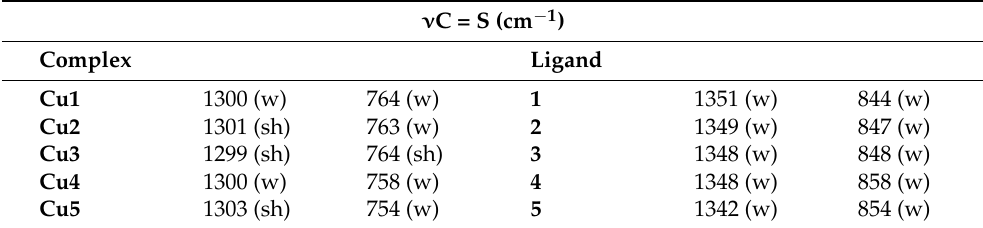
Figure 4. UV-Vis spectra in the range of 220–1400 nm for complexes Cu1–Cu5 . 2.2.3. XANES Comparative Analysis The copper oxidation state in the synthesized compounds was determined by XANES spectra comparative analysis. Therefore, we measured the Cu K-edge spectra of the complexes as well as two reference oxides: Cu 2 O and CuO. The copper K-edge corresponds to dipole-allowed 1s–4p transition and shifts to the higher energy values with increasing metal oxidation state. Figure 5 presents the comparison of Cu K-edge spectra of two complexes: Cu2 (representative of alkylphenyltiourea derivatives) and Cu4 (representative of halogenphenylthiourea complexes), and the reference oxides. The absorption edge for Cu 2 O is at 8979 eV and for CuO at 8982 eV. The energy positions and